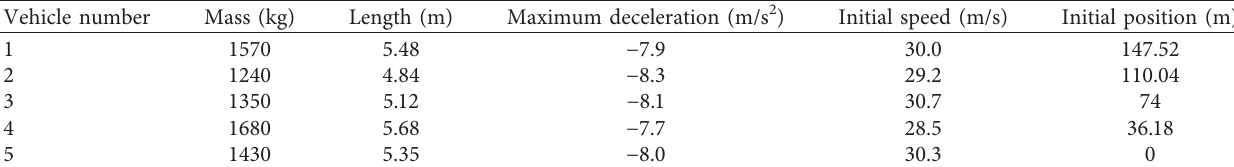
Table 1: Vehicle simulation parameters.